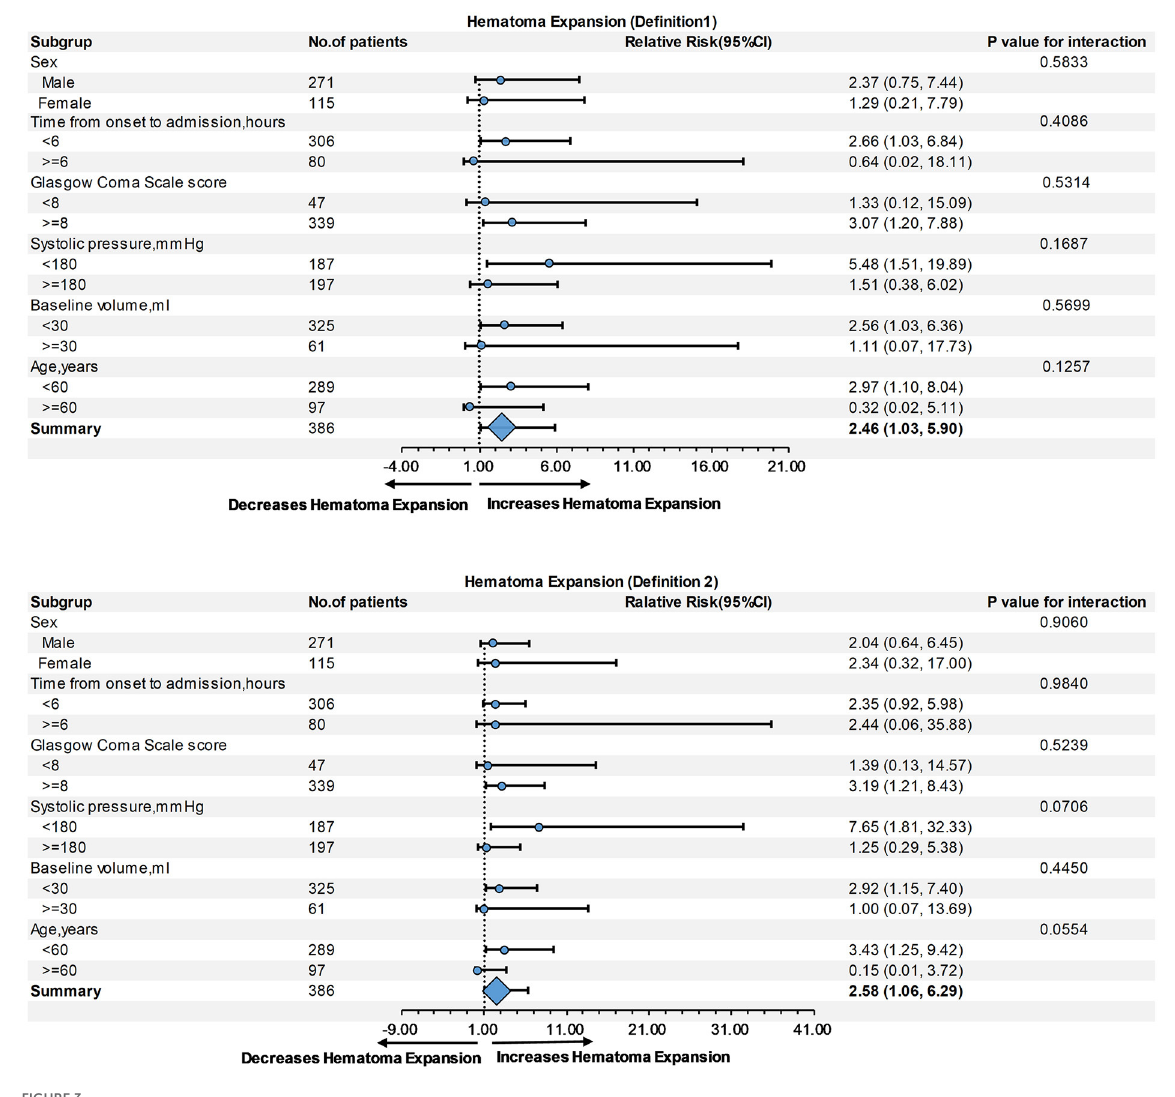
FIGURE3 Subgroup analysis of the relationship of monocyte count and hematoma expansion (HE) according to Definitions 1 and